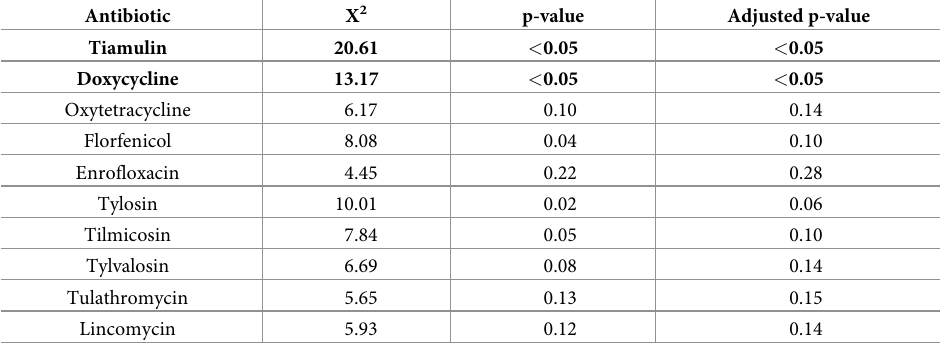
Significant differences are highlighted by bold